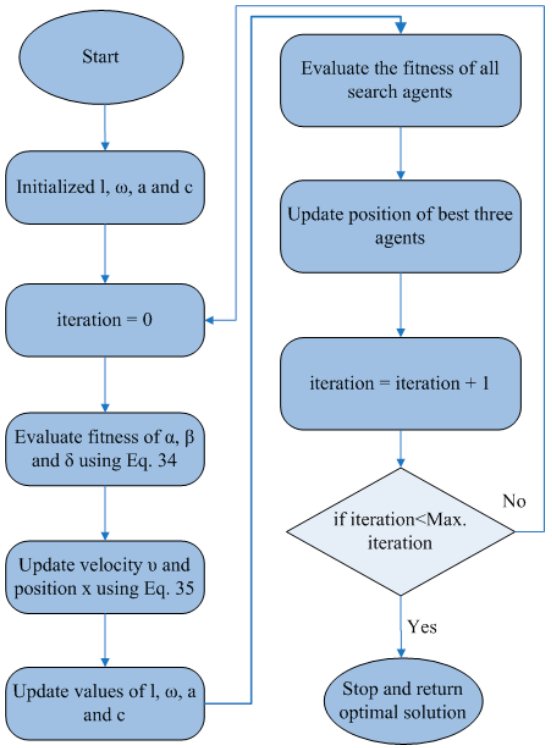
Figure 6. Flow chart of the proposed HPSO-GWO algorithm.